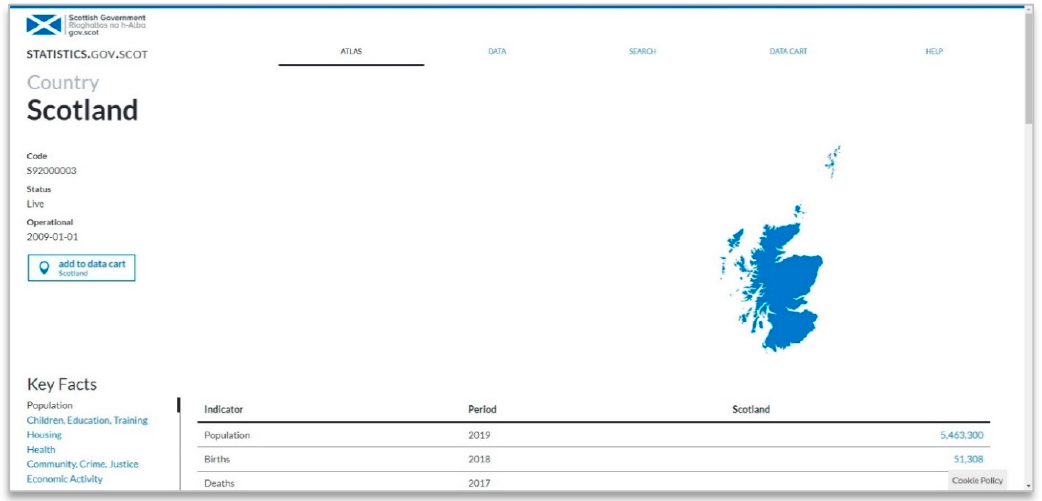
Figure 3. Homepage: Scottish Statistics Office Linked Data Browser. Retrieved from: https://statistics.gov.scot/atlas/resource?uri=http://statistics.gov.scot/id/statistical- geography/S92000003.